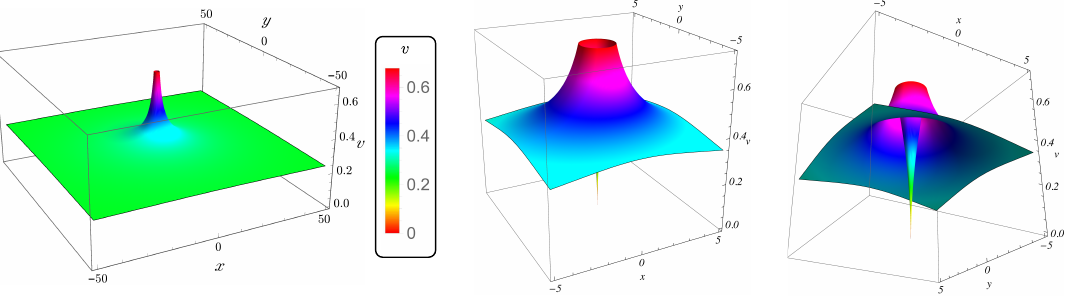
Figure 1. Case with ρ 1 , α = 1 and β = 0.1: the middle figure is a zoom view from above of the peak visible on the left figure. The figure on the righ t is the figure in the middle seen from